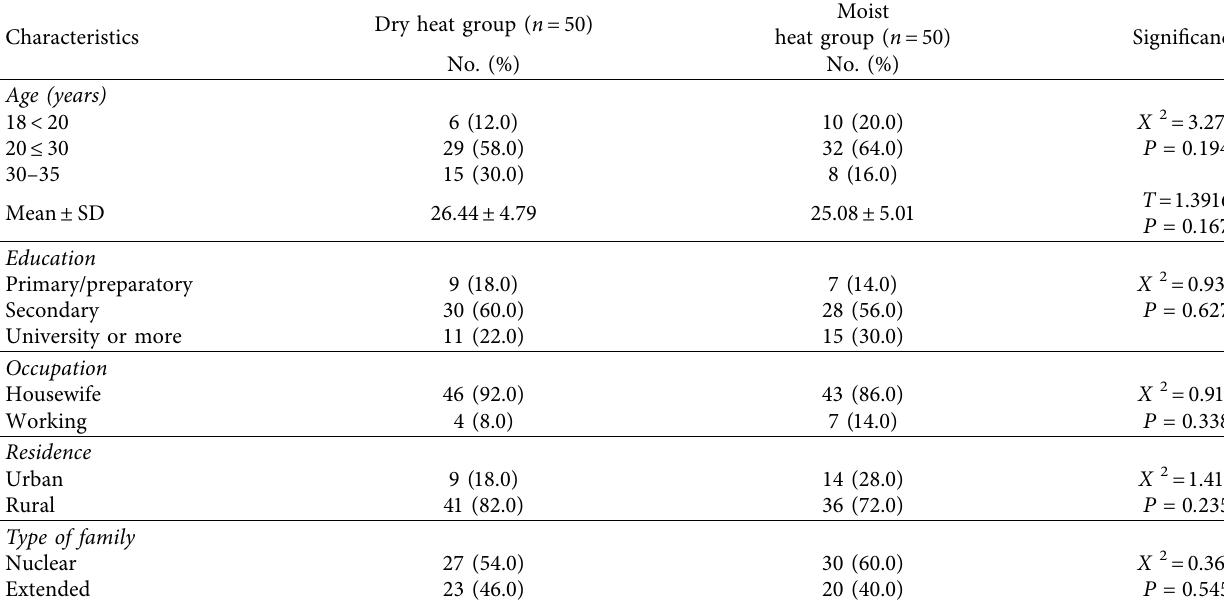
Table 1: Sociodemographic data of primipara